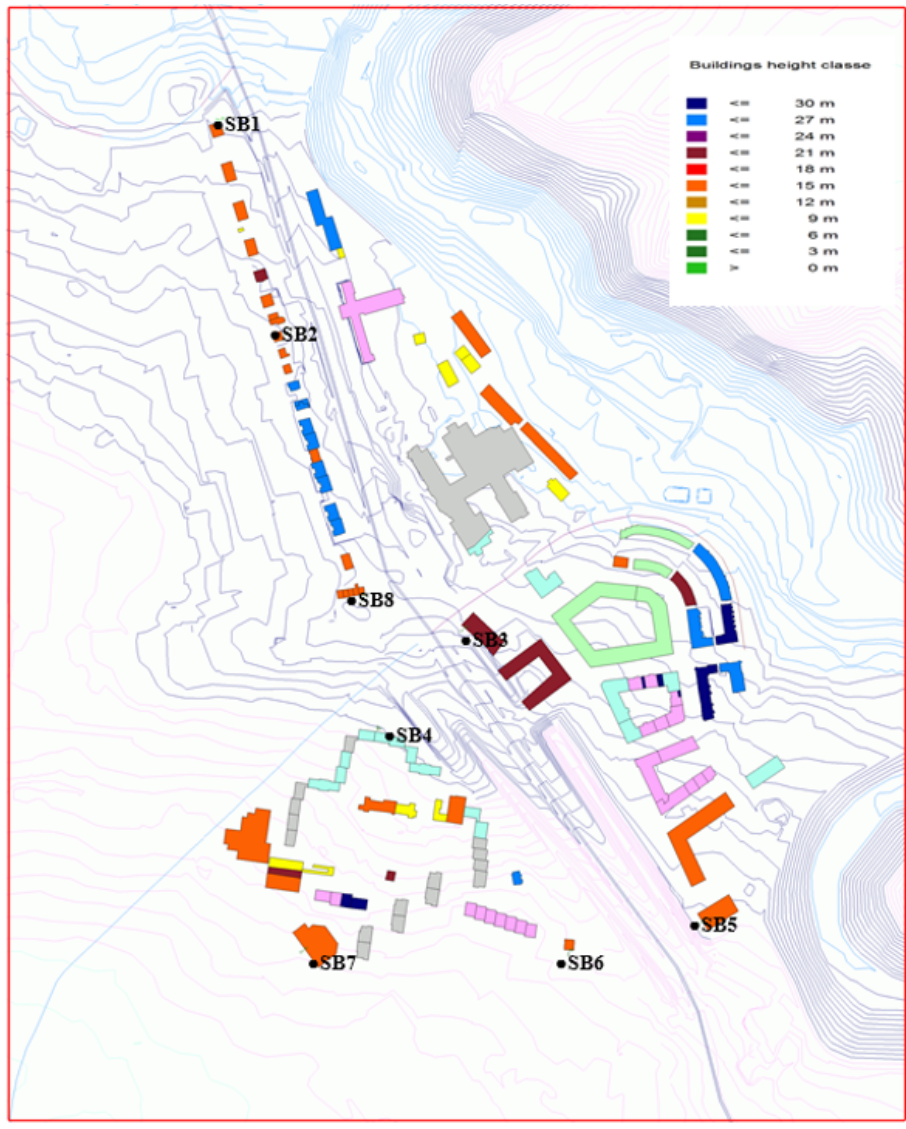
Figure 2: The modeled area showing the calculated monitored points (MP)